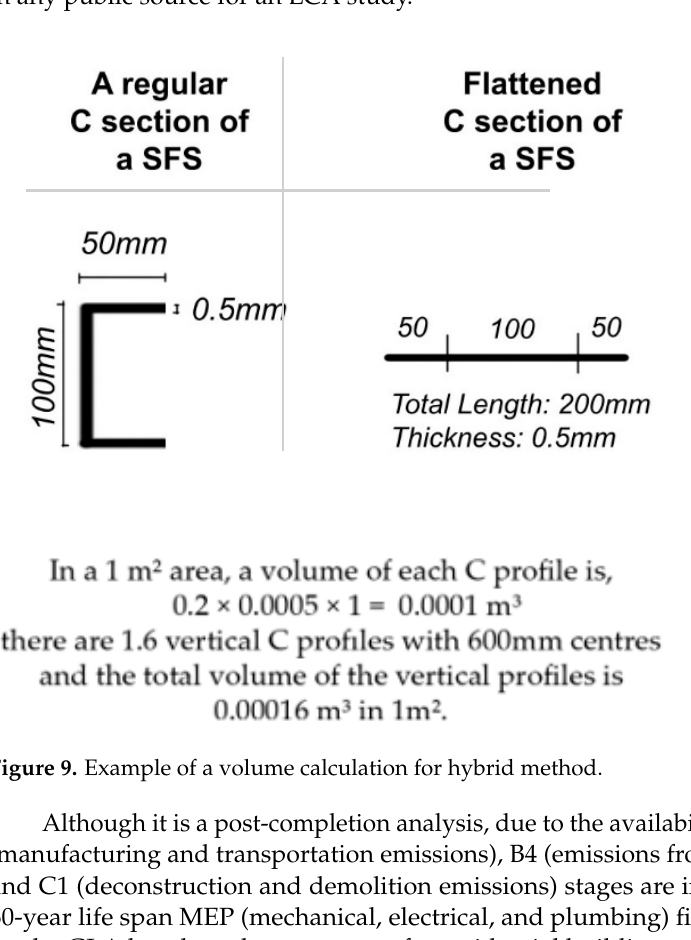
Figure 10. EVn6 LCA results compared against LETI and RIBA targets for residential buildings.